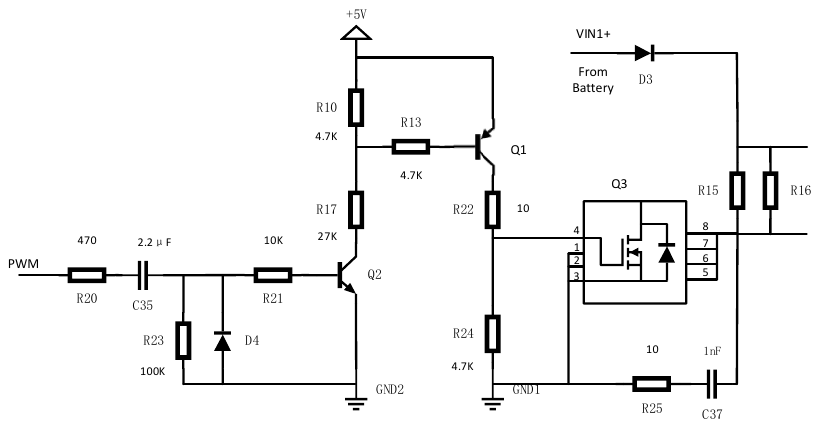
Figure 6. Partial internal resistance sampling circuit.